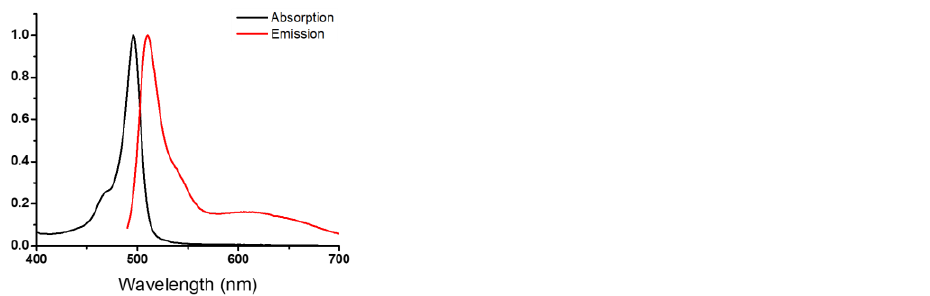
Figure 2. Normalized absorption and fluorescence spectra of BODIPY 1 in acetonitrile ( λ max = 480